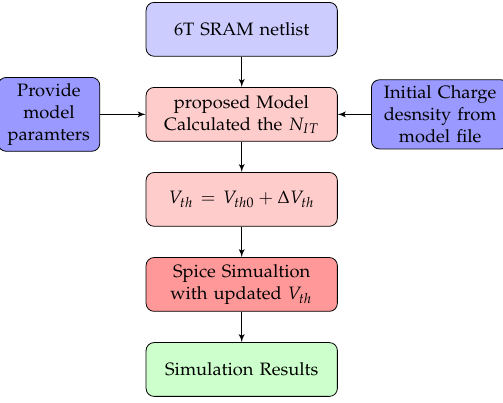
Figure 14. Proposed flow chart for the SRAM circuit simulation in a spice-based circuit simulation environment using the proposed model.